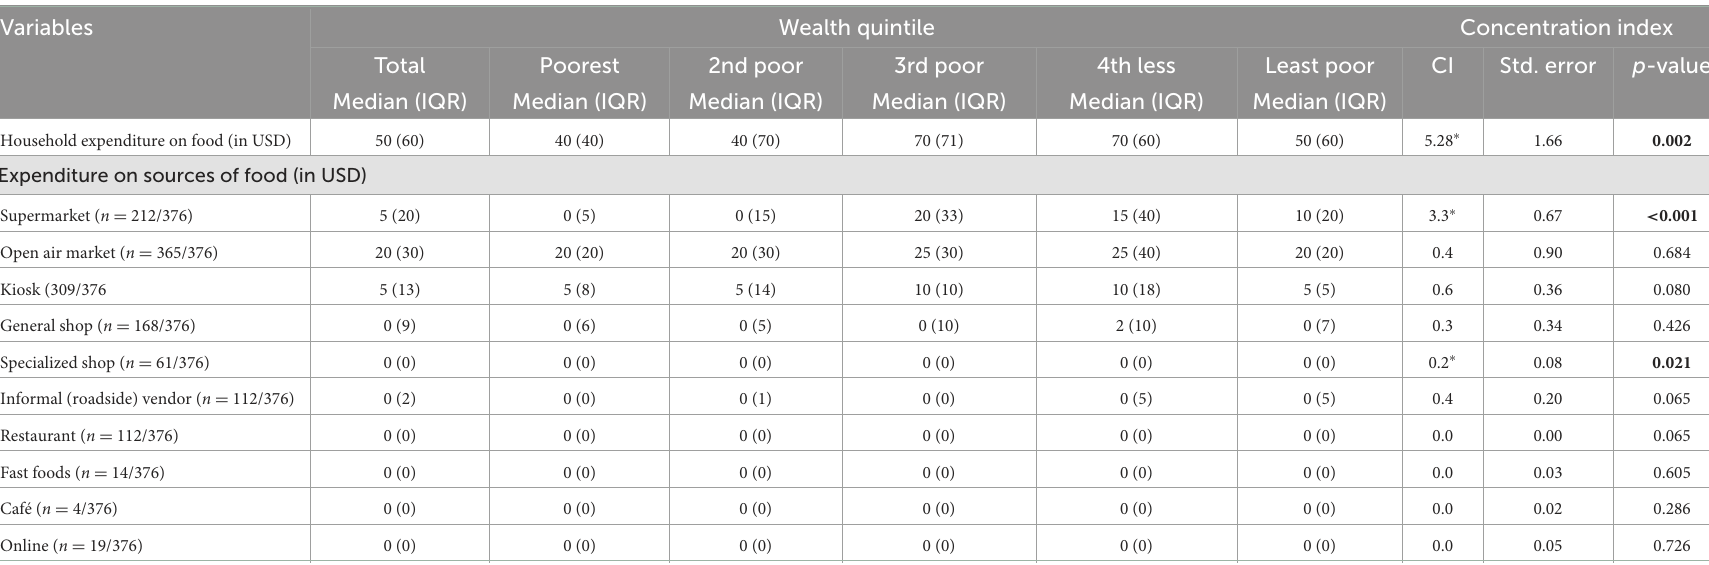
TABLE 5 The median amount spent on food by households and inequality in the amount spent on food across different socioeconomic status in Western Region, Kenya ( n = 376).